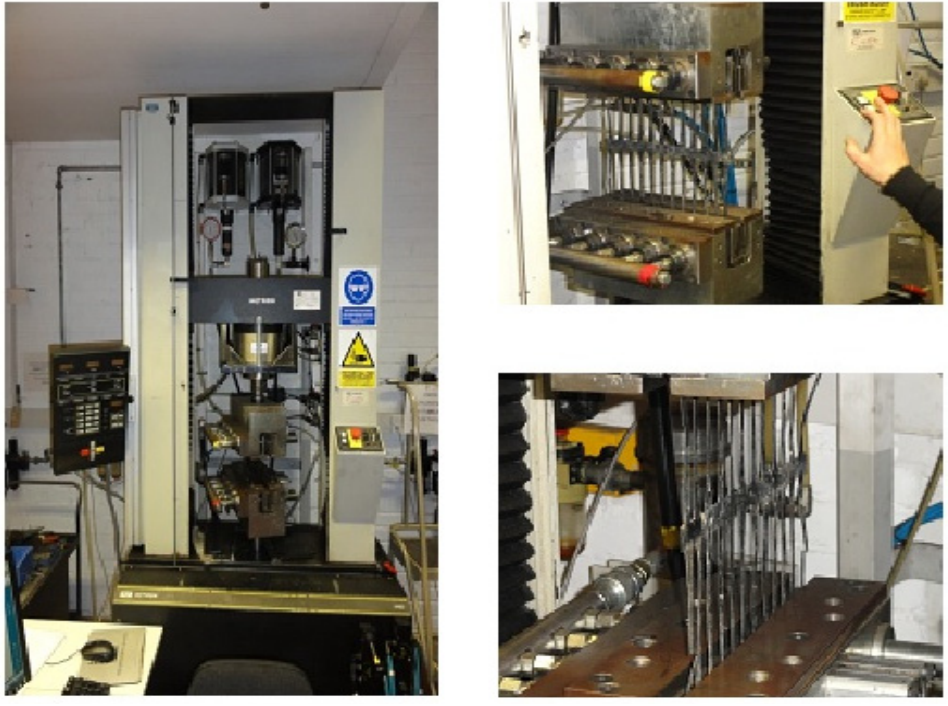
Figure 5. Laboratory equipment for tensile testing.